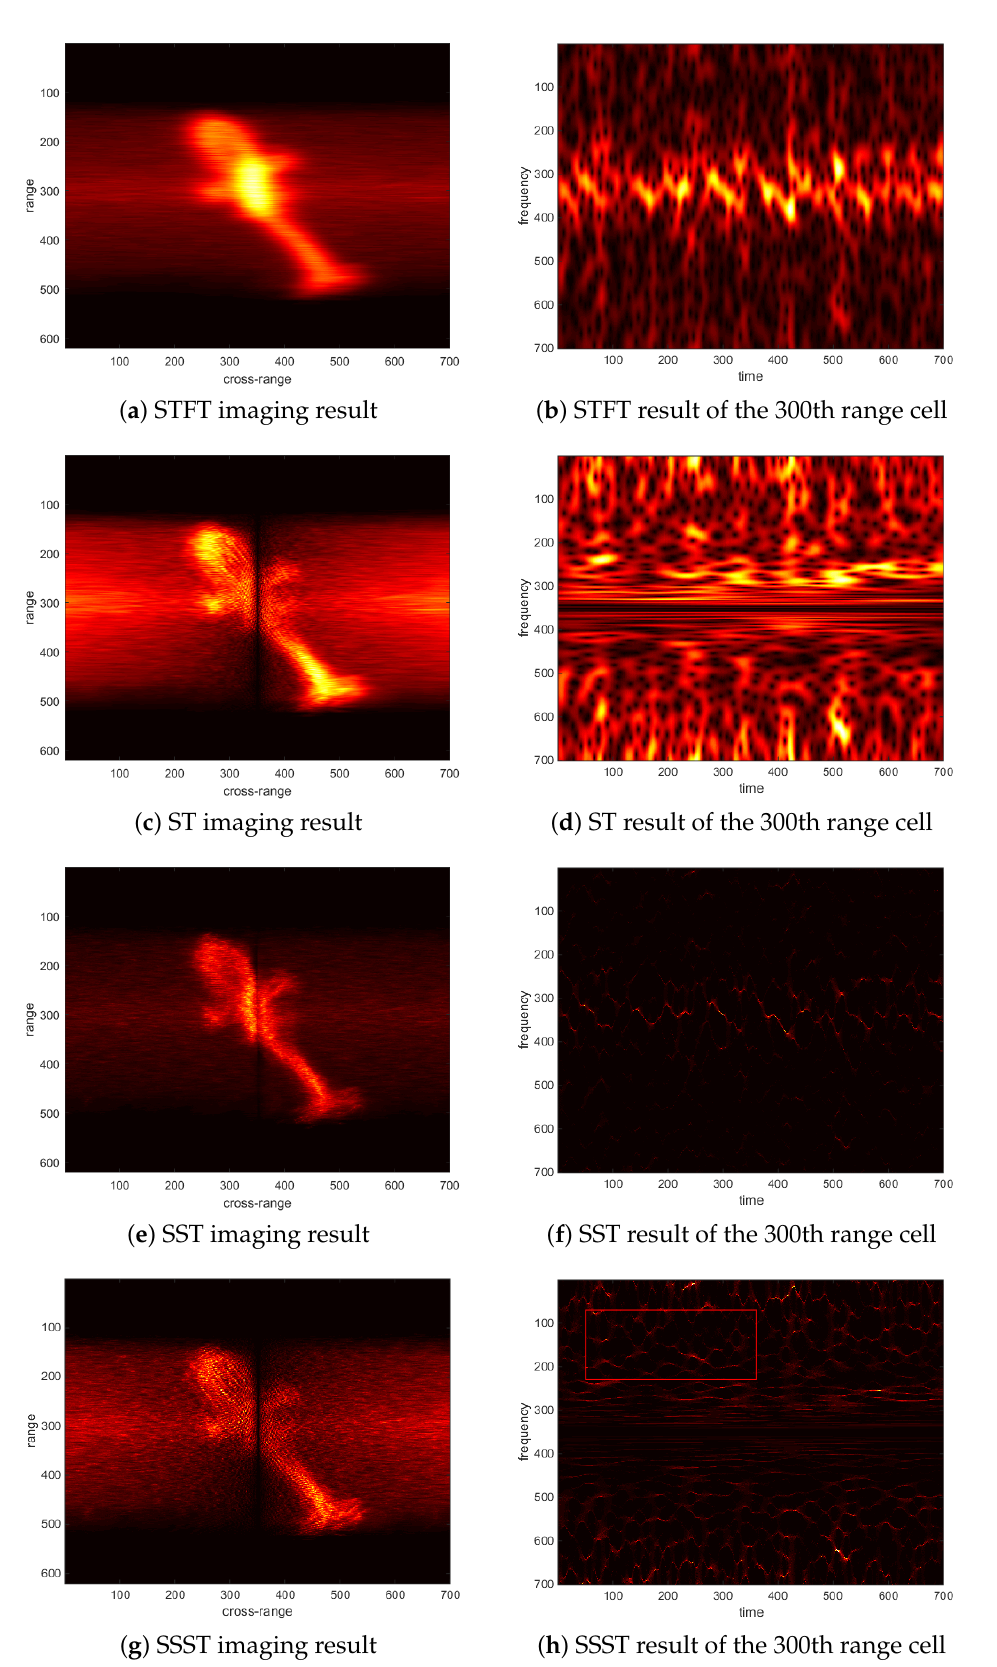
Figure 6. Results of target with a main rotor speed of 20